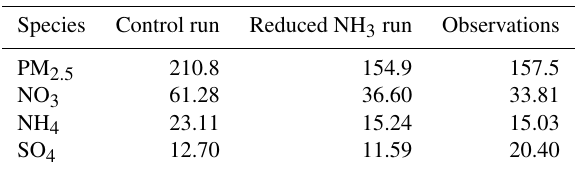
Table 5. Mean concentrations (in µgm − 3 ) at IAP during 21–25 Oc- tober 2014.